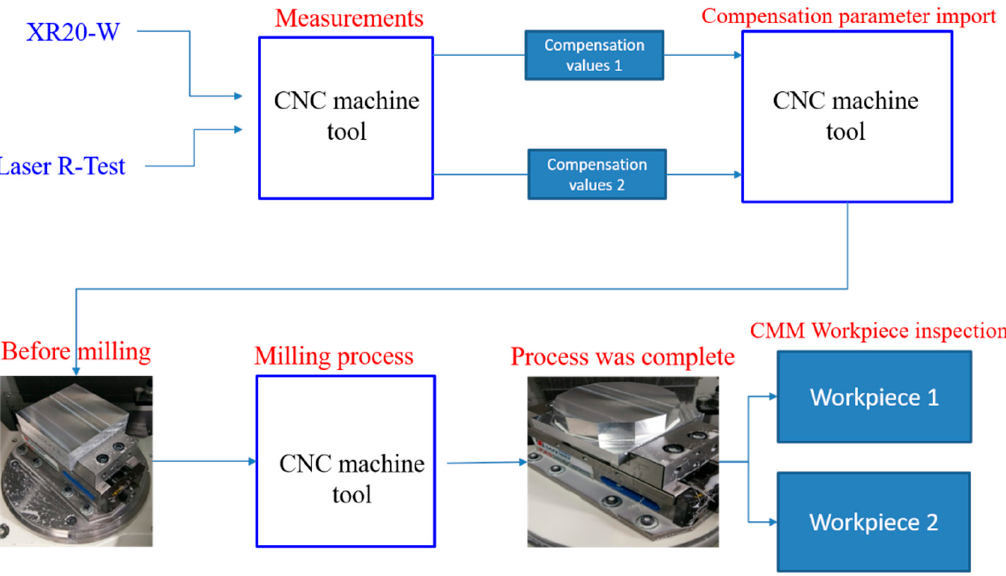
Figure 25. Experimental process.